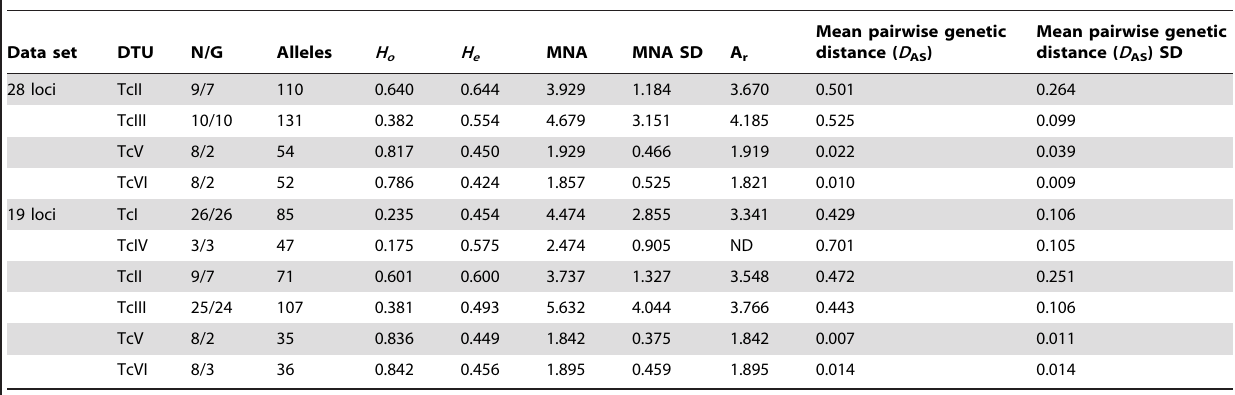
Table 4. Multilocus microsatellite summary